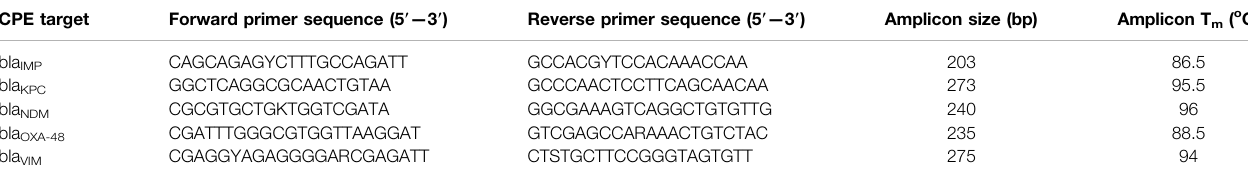
TABLE 1 | Primer sets developed in this study for the 5-plex PCR assay. CPE